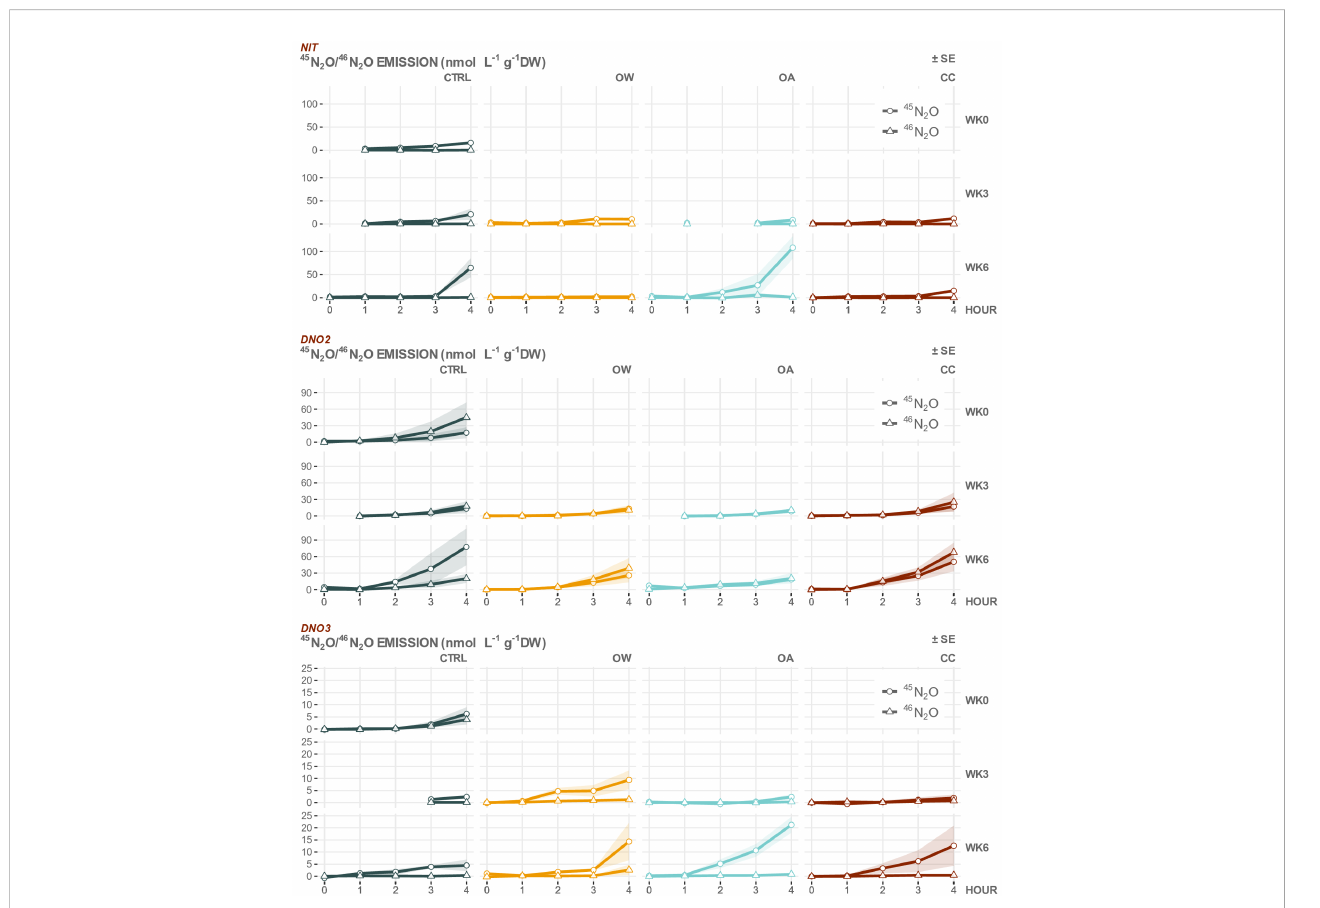
FIGURE 4 45 N 46 N -1 g -1 DW ± SE shaded area ) of M. edulis before seawater manipulations [ WK0 ] and after three [ WK3 ] 2 O (circles) and 2 O (triangles) emission (nmol L or six [ WK6 ] weeks of manipulations with 3 N-tracers targeting nitri fi cation [ NIT ], nitri fi er denitri fi cation [ DNO2 ] or coupled nitri fi cation-denitri fi cation [ DNO3 ], in which NH + 4 , NO (cid:1) 2 or NO (cid:1) 3 act as a precursor to N 2 O emission, respectively, in 4 experimental treatments [CTRL: control, OA: ocean acidi fi cation, OW: ocean warming and CC: climate change]. Missing data due to faulty GC-IRMS. Note difference in scale